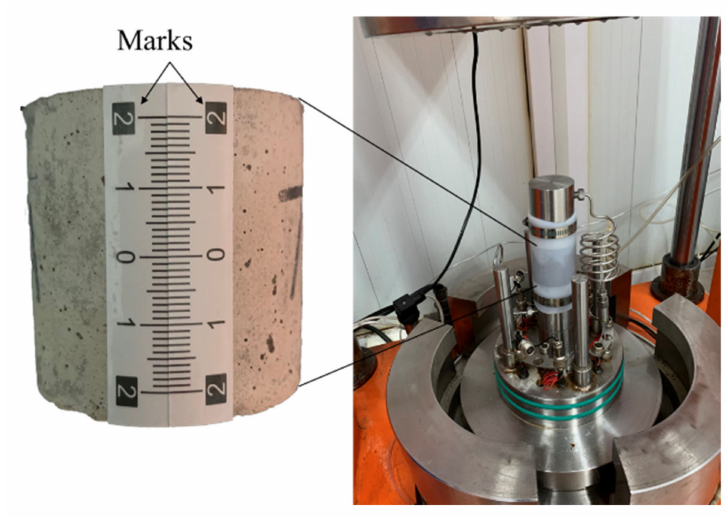
Figure 8. Sample